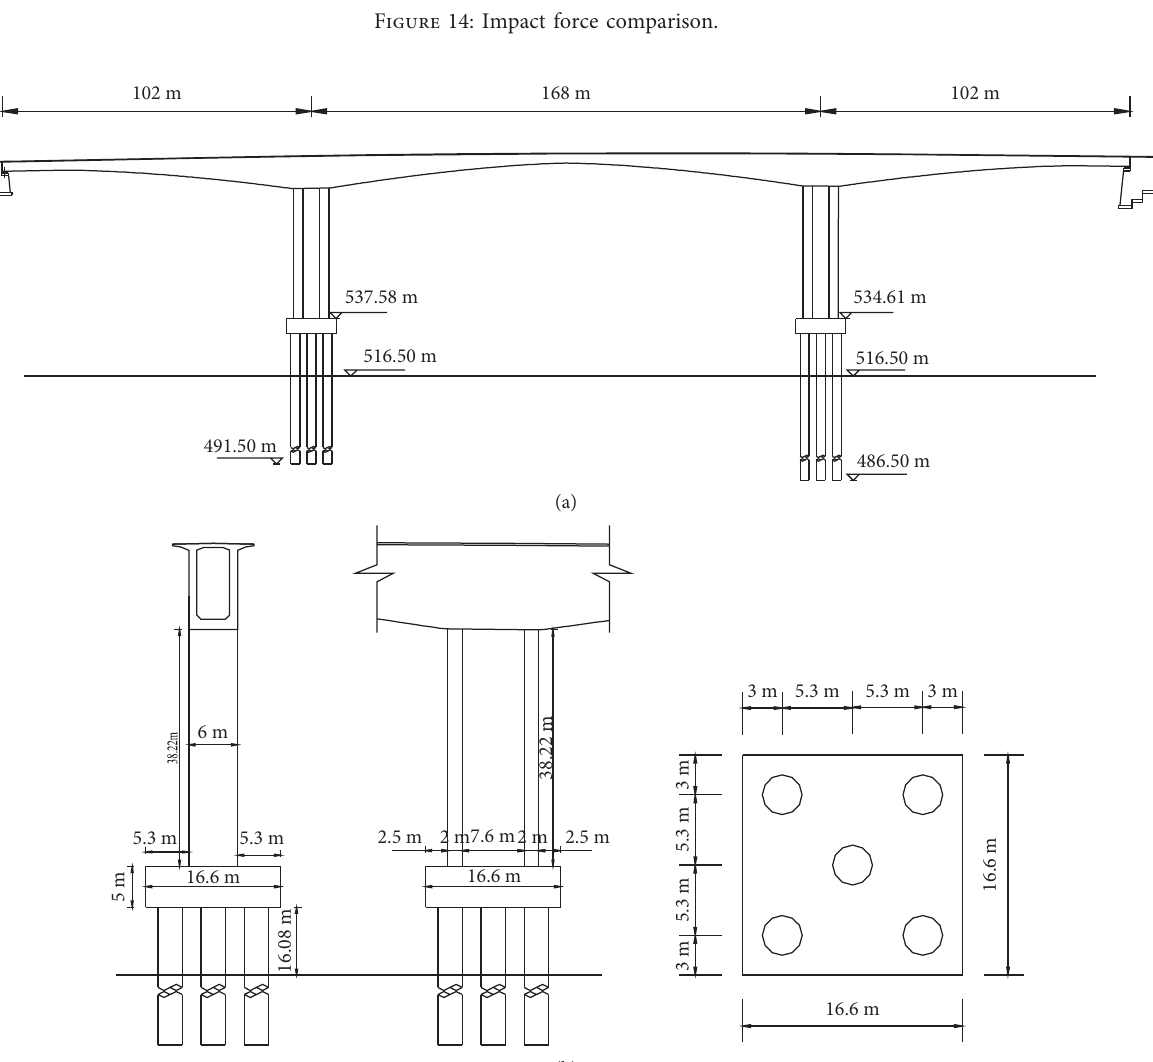
Figure 15: Configuration of the bridge. (a) Elevation view. (b) Left: side view of the pier; bottom middle: front view of the pier; and right: plan view of the